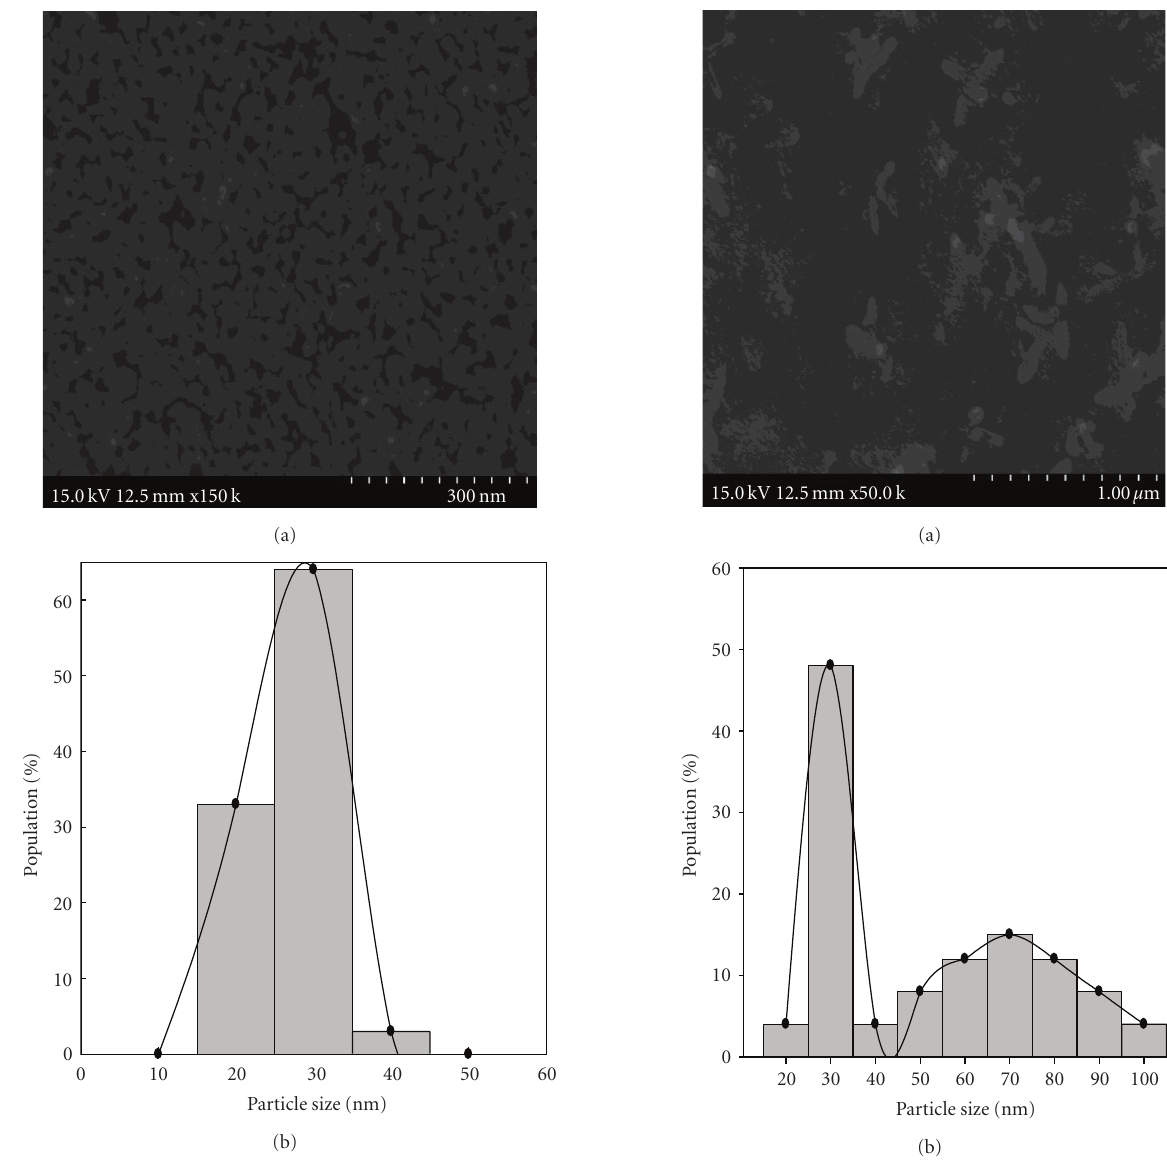
Figure 7: H-TTIE-TiO 2 thin film morphology after annealing at 500 ◦